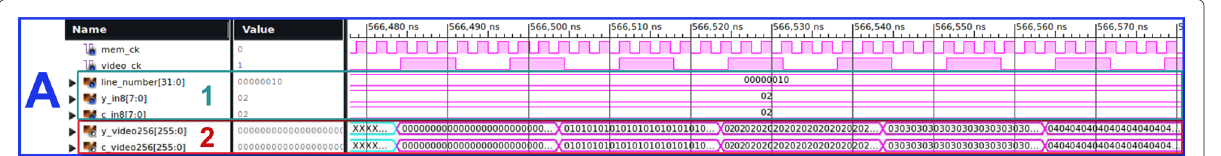
Fig. 8 The simulation screenshot represents the macroblock extraction process